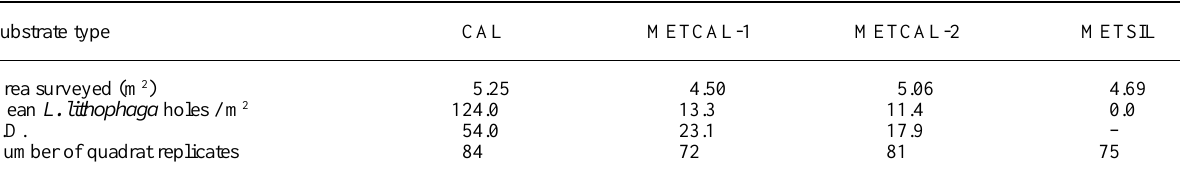
2000).T F IG . 7. – Densities of recently-settled juvenile spiny lobsters Palin- urus elephas at 10-15 m depth in the first week of August in the three metamorphic rock areas (METSIL, METCAL-1 and MET- CAL-2) and in the sedimentary non-metamorphosed limestone calcareous rock study area F IG . 8. – Median size and size range of juvenile spiny lobsters Palinurus elephas during the study period (July 1998-January